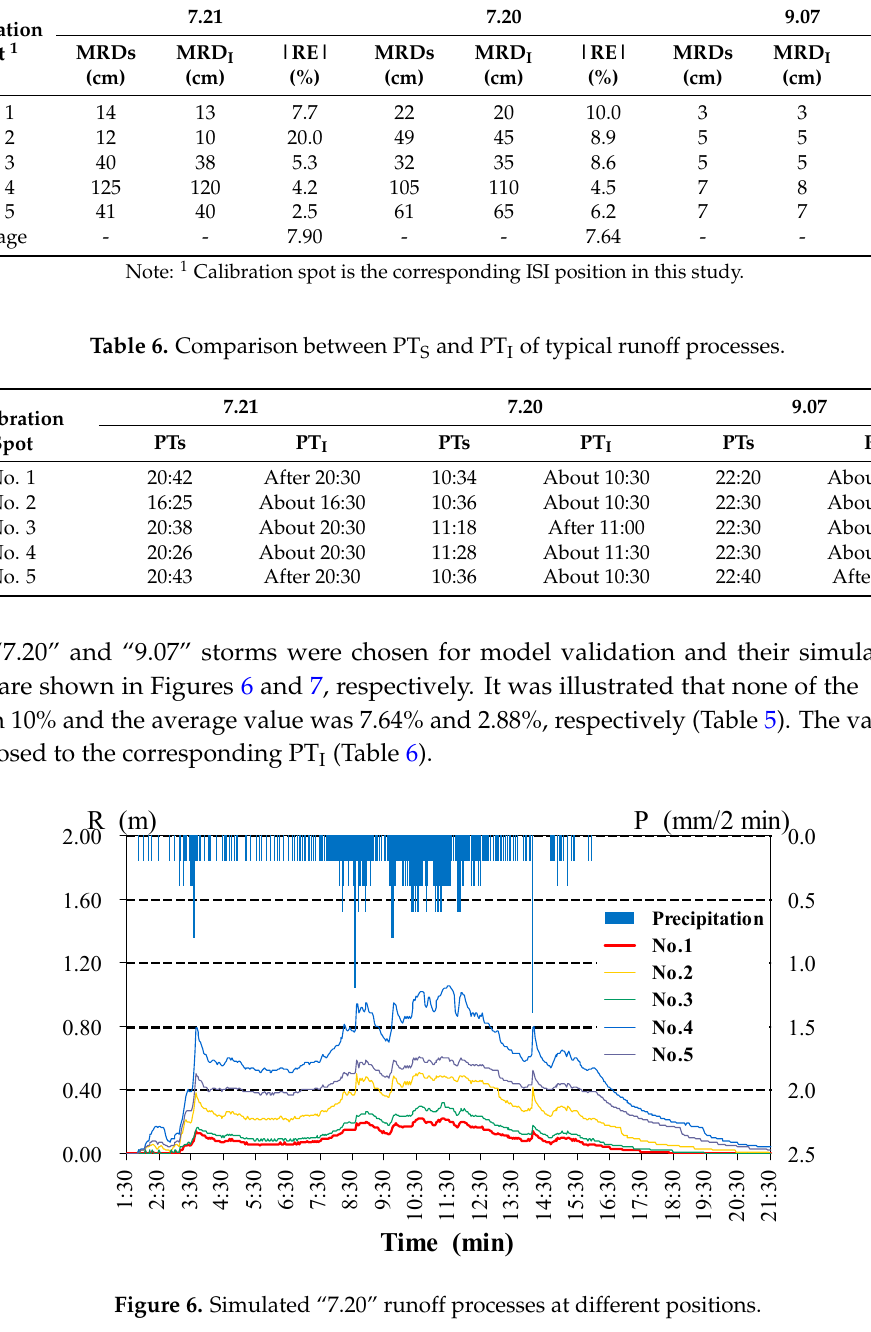
Table 5. Comparison between MRD S and MRD I of typical rainfall processes.